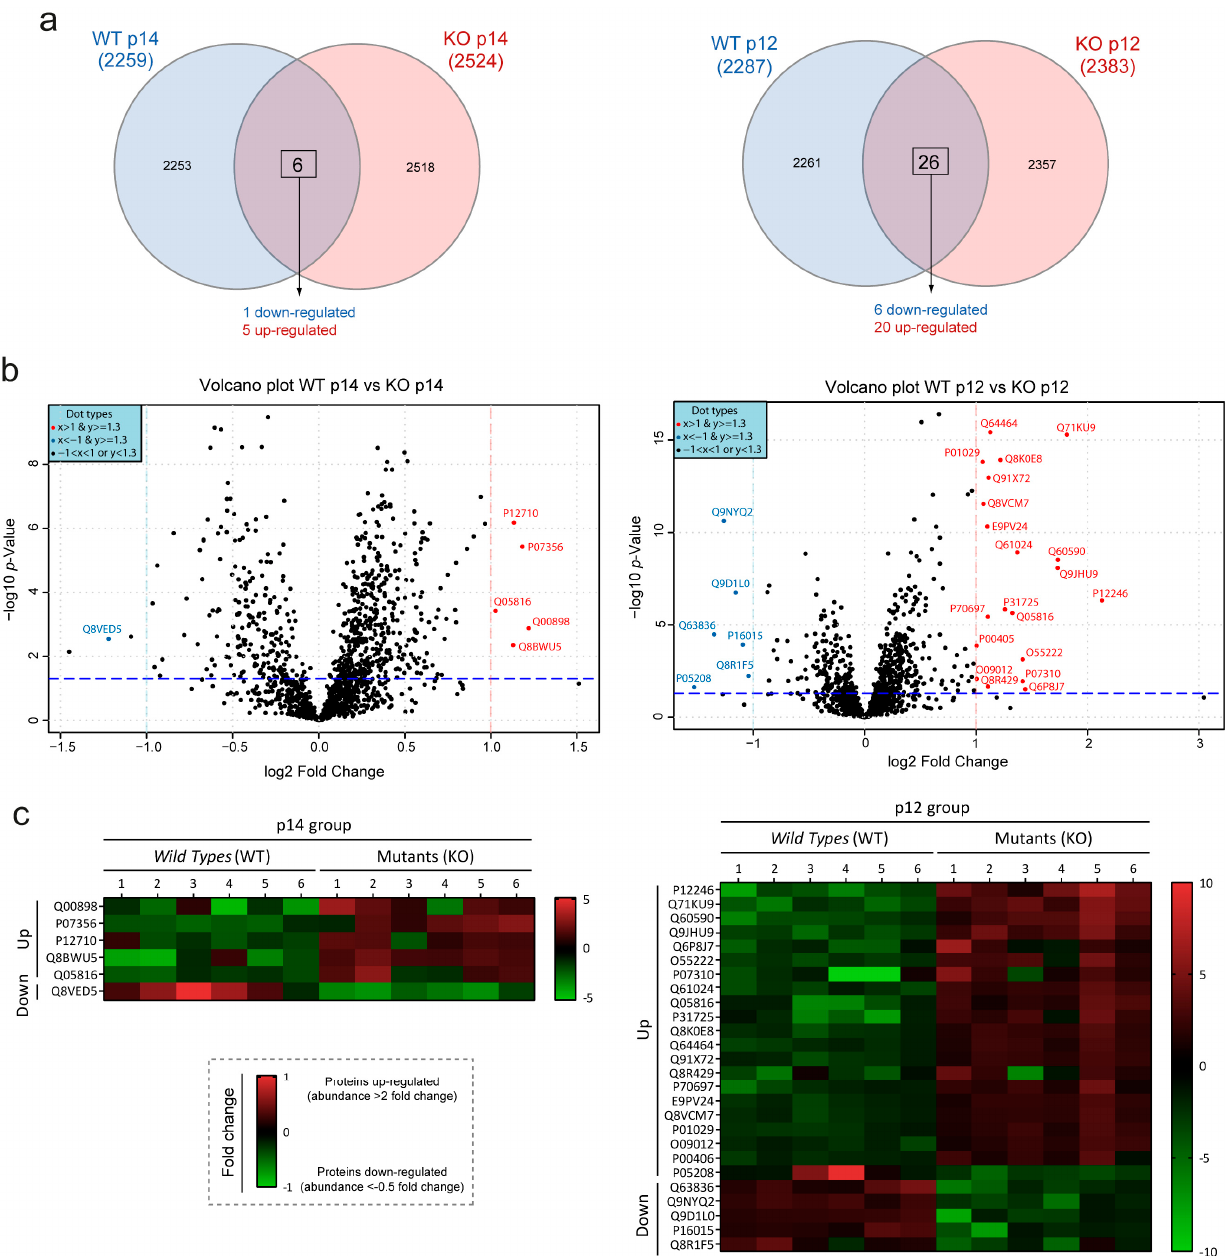
Figure 3. Graphic representation of proteins with altered abundance in hepatic cystogenesis. ( a ) Quantitative Venn diagrams showing the proteins with significant alterations (up ‐ and down ‐ regulated) of p14 ( left ) and p12 ( right ) groups. See Table 1 for the complete list of proteins with significant differences. ( b ) Volcano plots comparing Wild Type and Mutant samples in p14 ( left ) and p12 ( right ) groups, respectively. Volcano plots showing proteins with significant differences of protein abundance ( p ‐ value < 0.05 and fold change > 2) up ‐ regulated (red dots) or down ‐ regulated (blue dots) in SWATH analysis. X ‐ axis shows the fold change of log(2) (the red and green lines show the 2 ‐ fold cut ‐ off up ‐ and down ‐ regulated, respectively) and Y ‐ axis shows –log(10) ‐ p ‐ value (blue lines shows the cut ‐ off point of a p ‐ value < 0.05). ( c ) The heat maps represent the significant differences in protein abundance between individuals according to the areas of the SWATH spectral library. Red represents the up ‐ regulated and green the down ‐ regulated proteins.